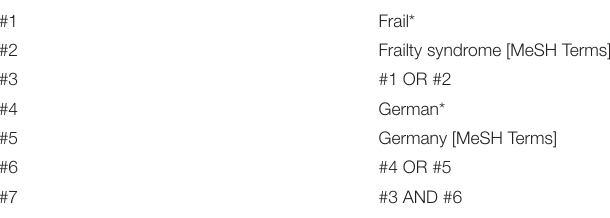
TABLE 1 | MEDLINE search